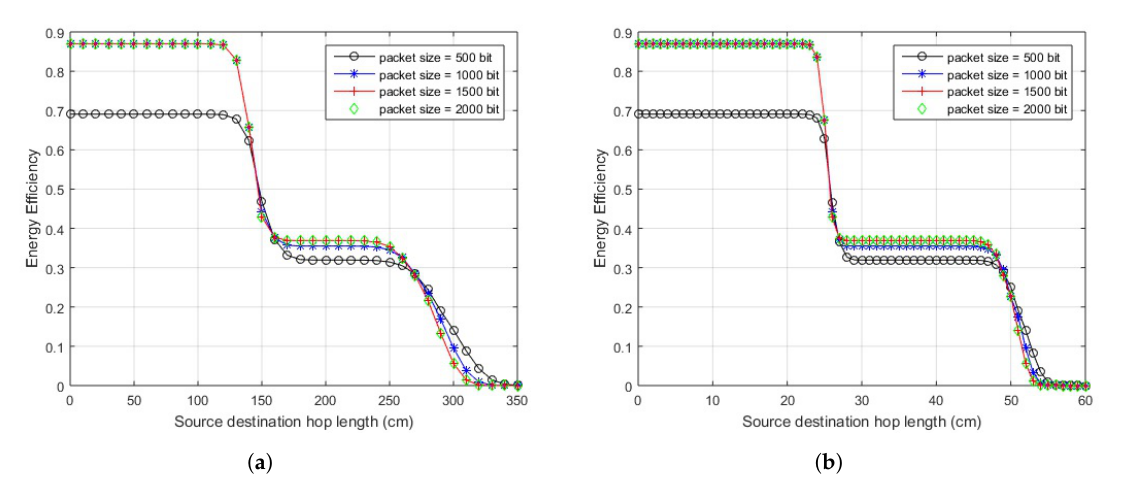
Figure 9. Energy efficiency over distance for proposed scheme (on-body communication). ( a ) energy efficiency over distance for proposed scheme (on-body LOS communication); ( b ) energy efficiency over distance for the proposed scheme (on-body NLOS